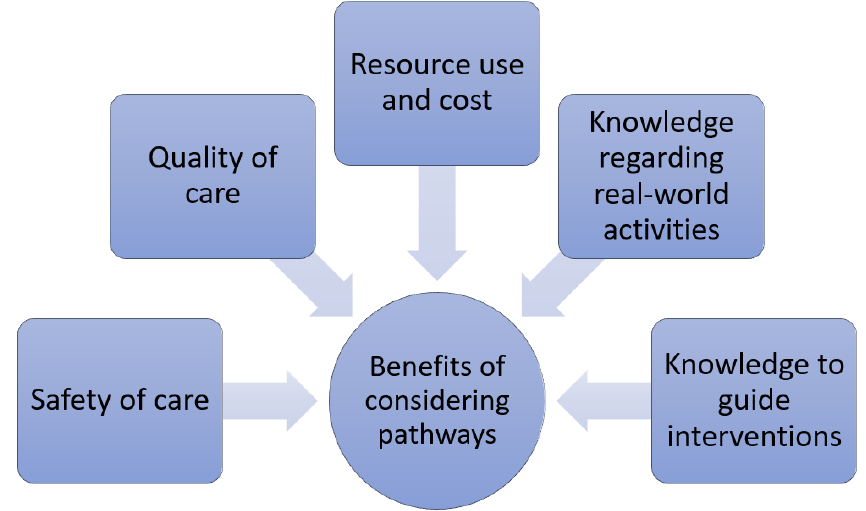
Figure 3. The benefits of considering pathways.